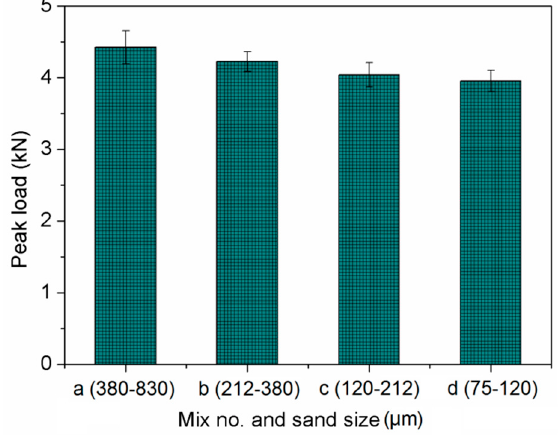
Figure 14. Critical effective crack length of cement-based composites.